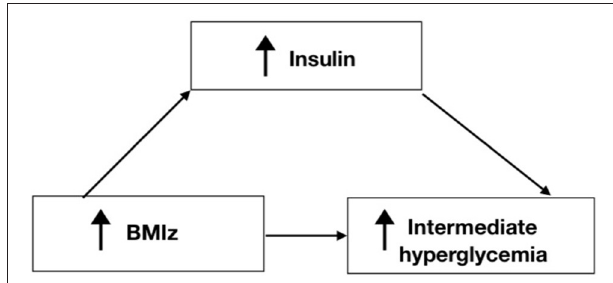
FIGURE 5 | Pathway of the mediation process for Insulin in the relationship between BMIz and Intermediate